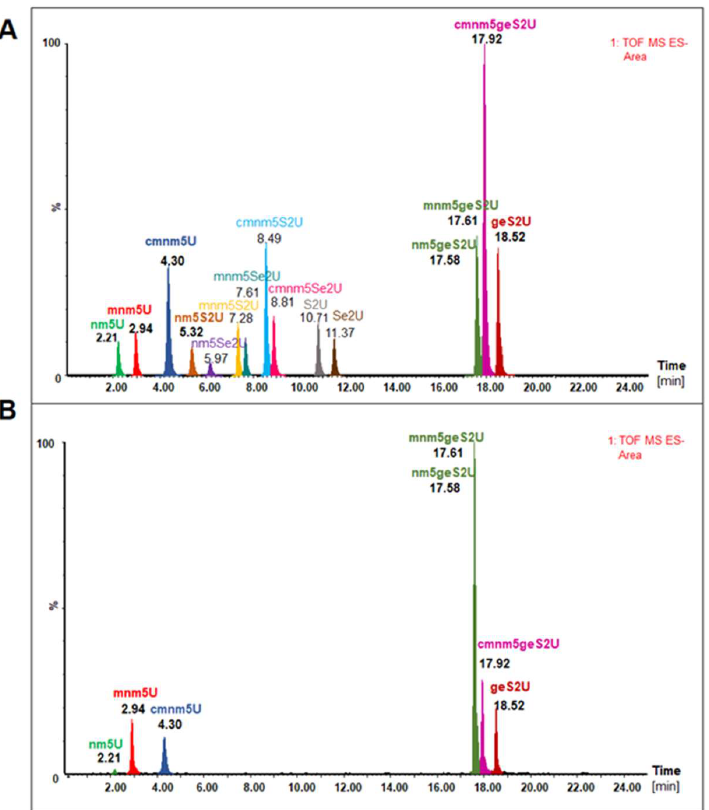
Figure 5. UPLC-PDA-ESI(-)-HRMS analysis of modified nucleosides that were present in the wobble position of tRNAs associated with the MBP–SelU protein: ( A ) chromatogram of the extracted ions (XIC) of the mixture of fifteen nucleoside standards (used in the same amounts); ( B ) modi- fied nucleosides present in the wobble position of tRNAs associated with the MBP–SelU protein. Chromatographic separation conditions are provided in Materials and Methods